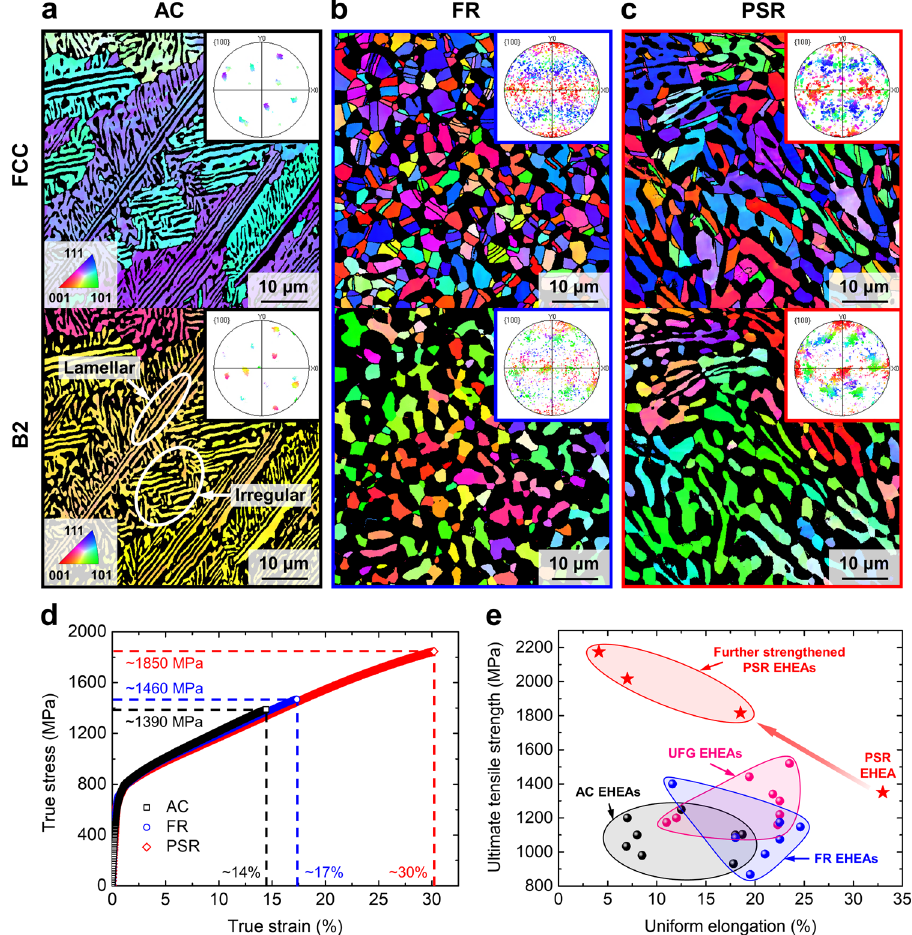
Fig. 1 | Microstructures and mechanical properties of the PSR EHEA. a – c Electronbackscatteringdiffraction(EBSD)inversepole fi gure(IPF)mapsofthe FCC (upper row) and B2 (lower row) phases in the AC, FR, and PSR EHEAs, respectively. The insets show the corresponding pole fi gure (PF) maps. d Tensile